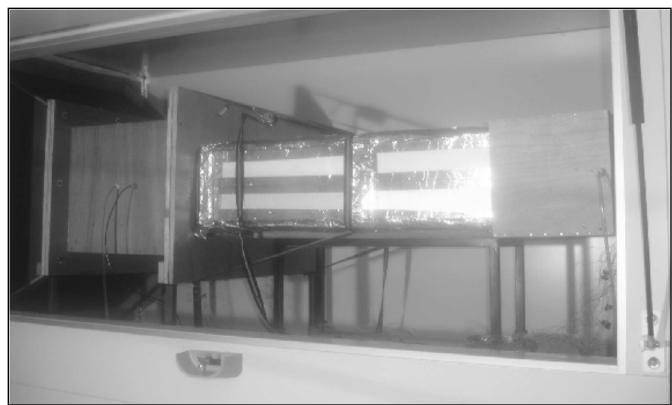
Figure 2. Photograph of the storage component installed in the closed ‐ loop air ‐ supply system.